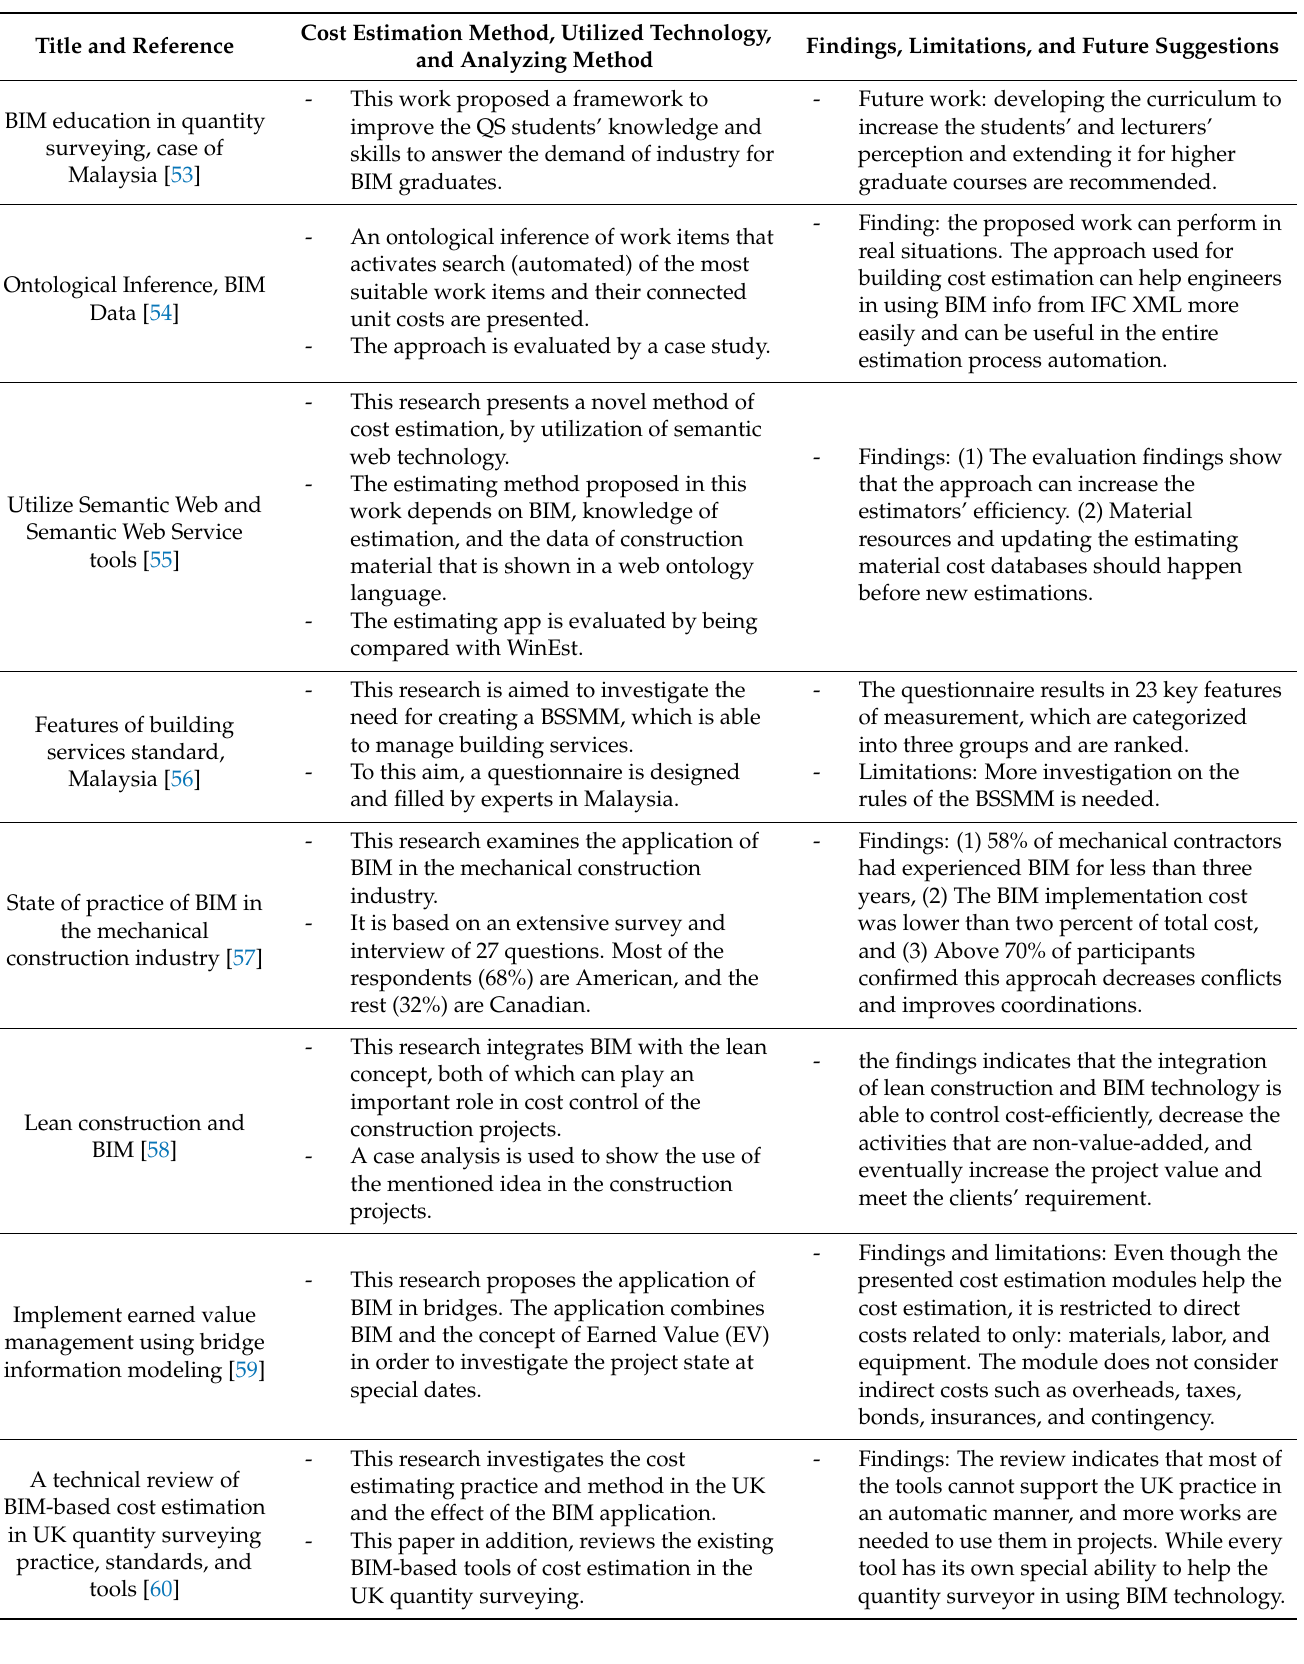
Table 6. Summary of key papers related to digital modeling and cost